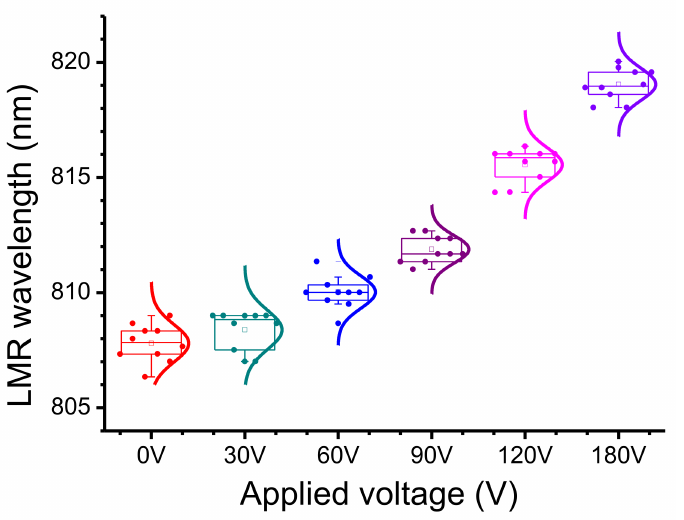
Figure 3. The distribution of lossy mode resonances (LMR) wavelengths for 1% BSA for applied voltages from 0 to 180